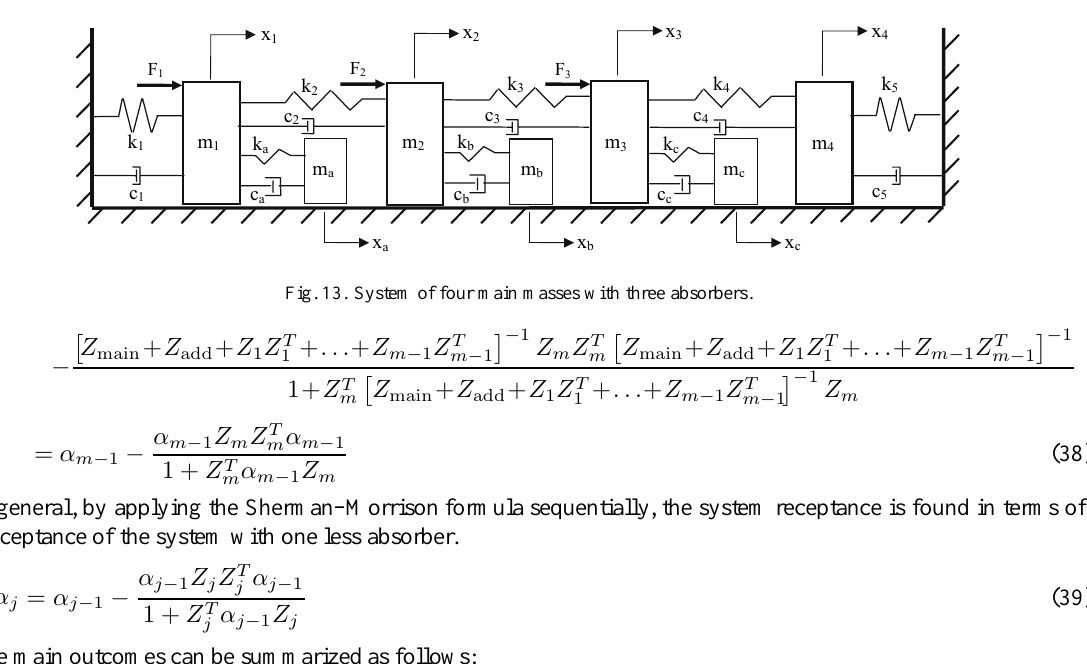
Fig. 12. Displacement of main mass 2, goal function is (0.8x 1 + 0.2x 2 ) .